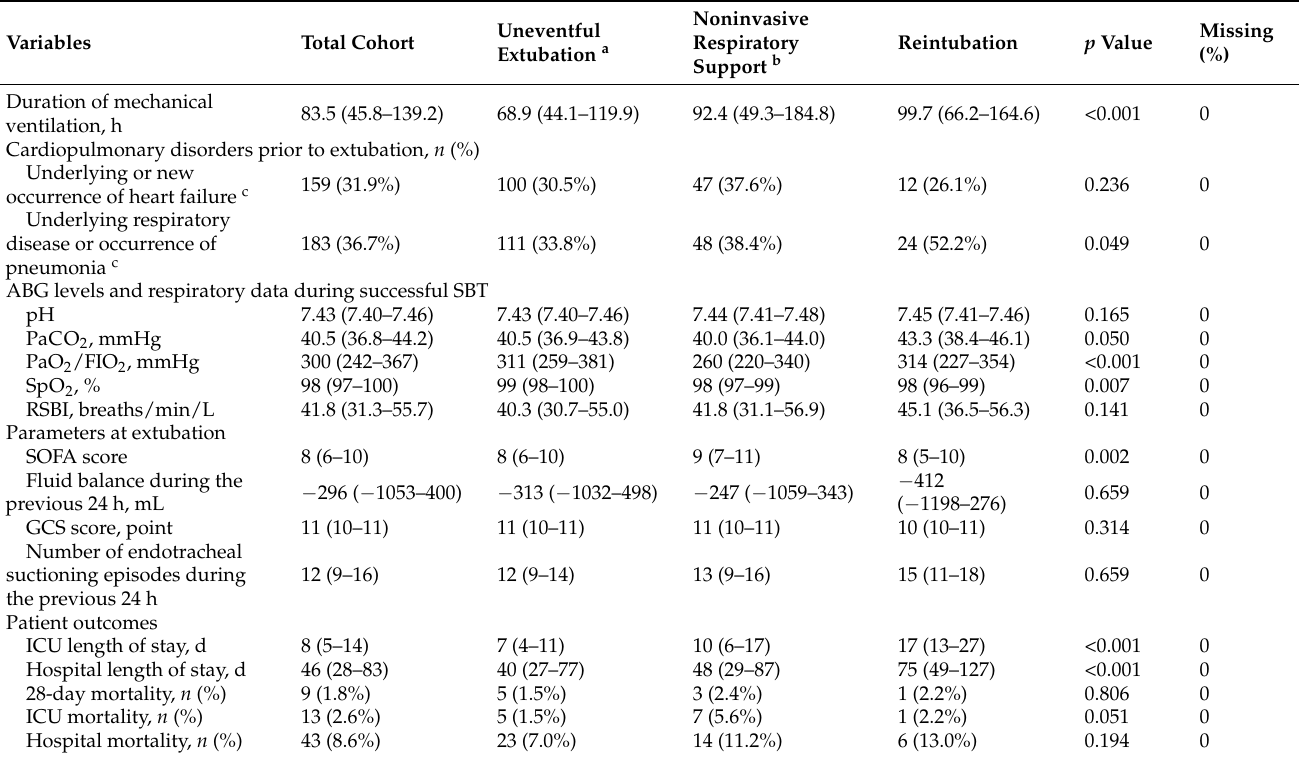
Table 2. Data prior to extubation and patient